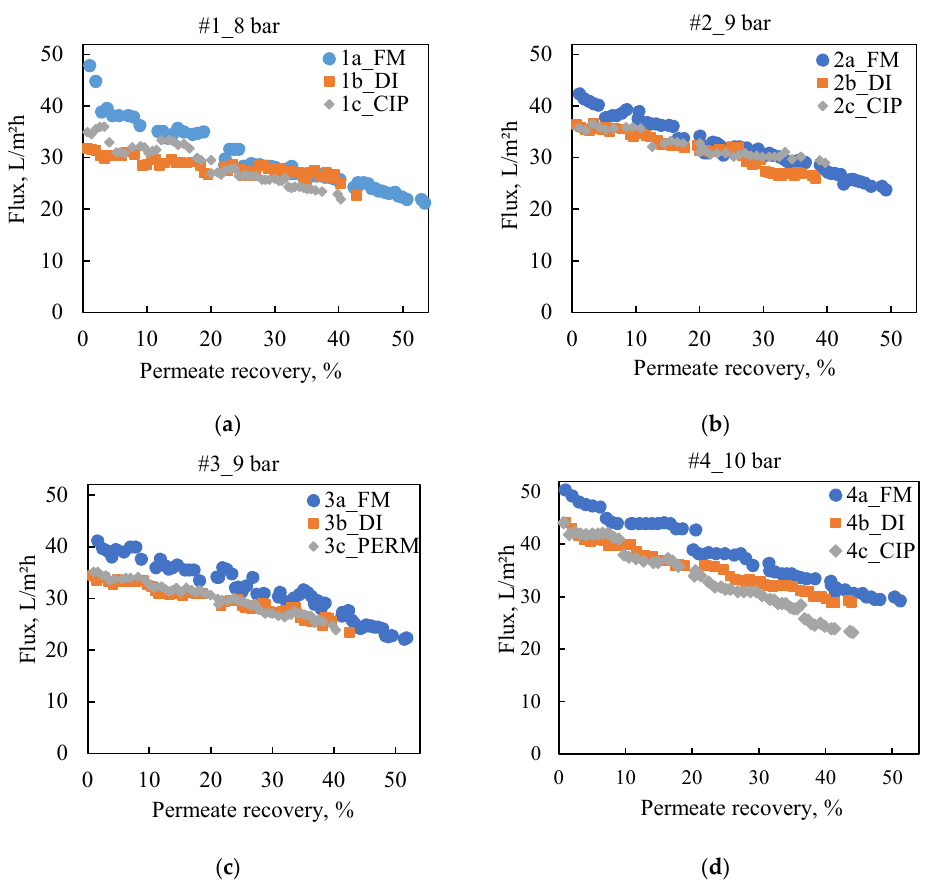
Figure 6. Flux variation versus permeate recovery of the test series #1-#4. Panels: ( a ) Feed S3 (#1_8 bar); ( b , c ) Feed S5 (#2_9 bar & #3_9 bar); and ( d ) Feed S4 (#4_10 bar). Table 2. Estimation of foulant species surface density; dissolution tests of NF90 membrane specimens after the test series #1–#4 with HCl 60 mM and NaOH 25